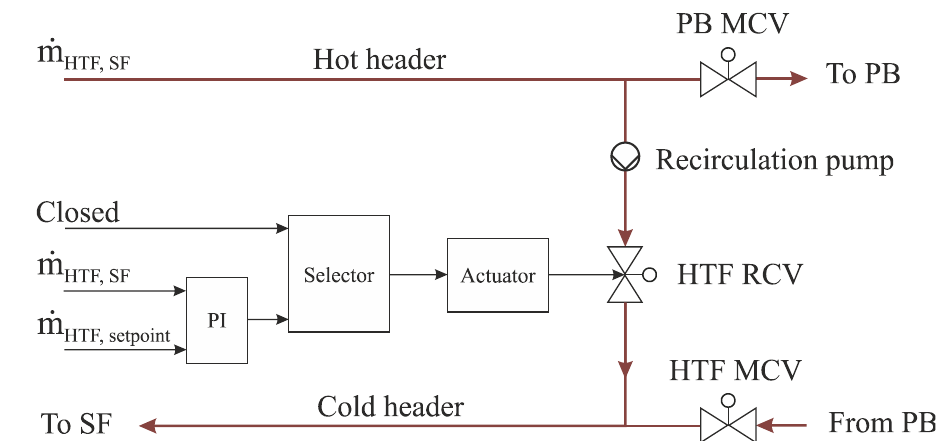
Figure 8. HTF recirculation control valve (simplified).